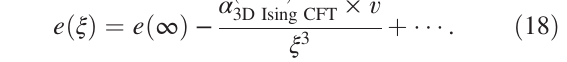
ð iPEPS ; ∞ Þ c and